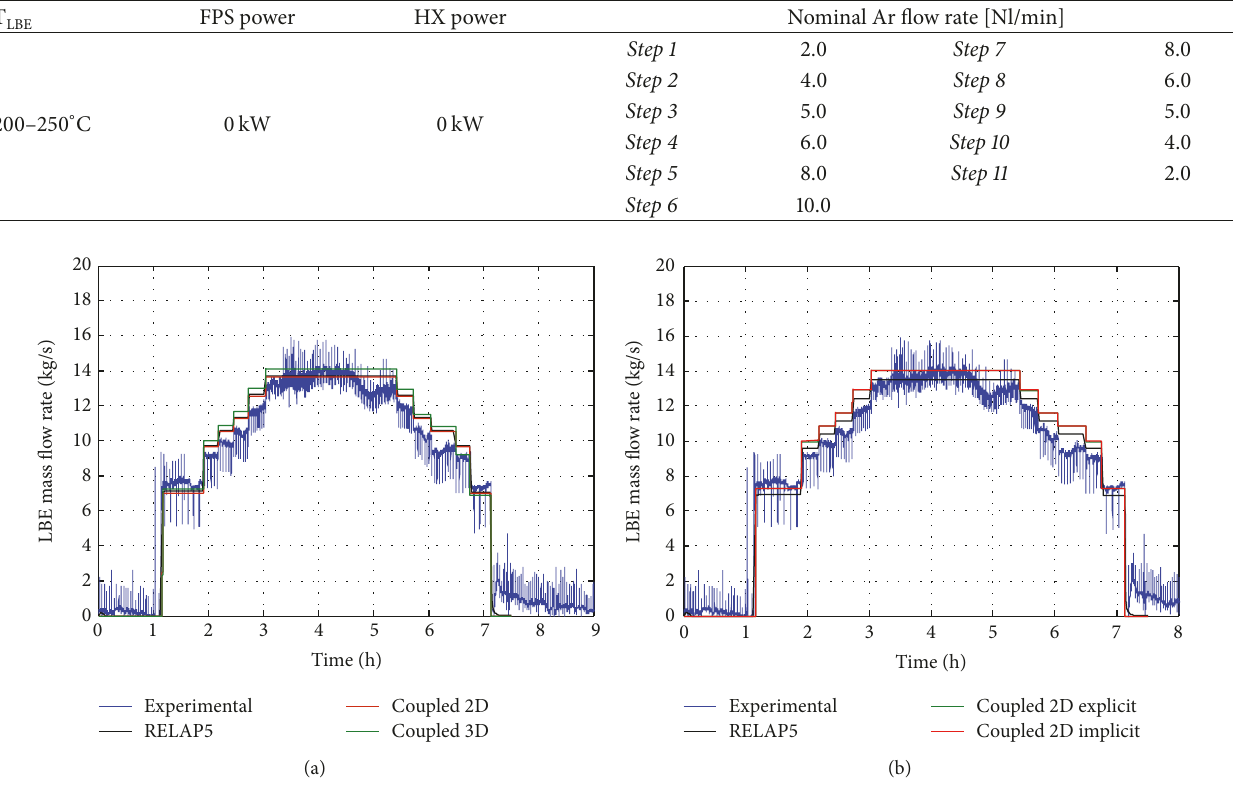
Figure 7: Time trend of the LBE mass flow rate for Test 206 in NACIE facility.